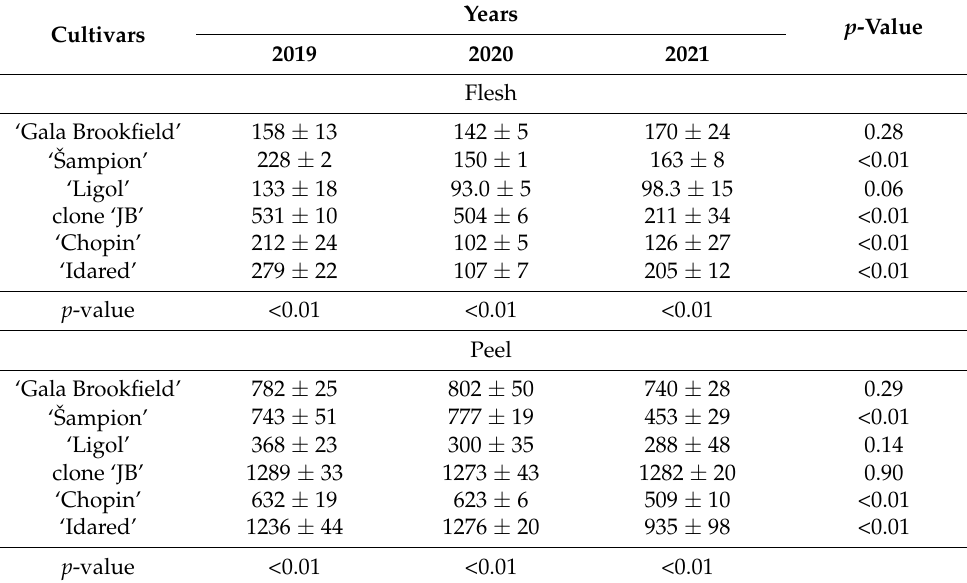
Table 7. The values of total polyphenols content (mg · 100 g − 1 FW) for flesh and peel of apples depending on cultivars and years of